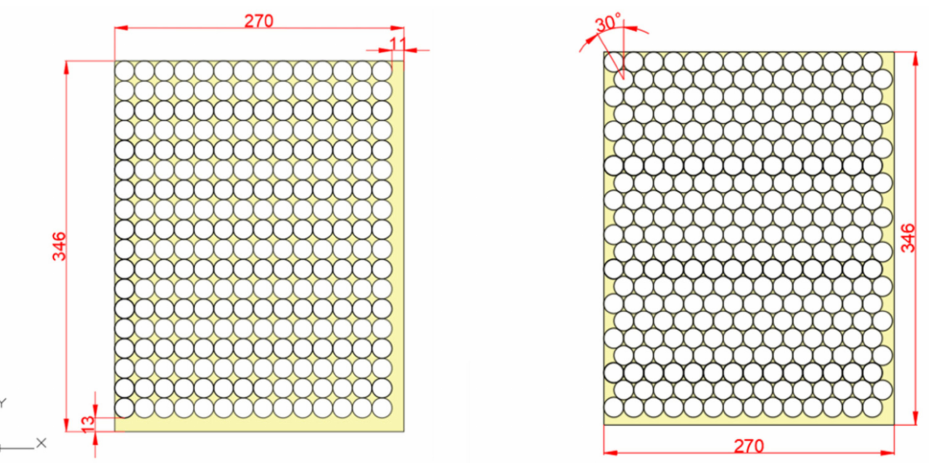
Figure 8. Reference module schematic with cylindrical cells arranged according to straight packing ( left ) and offset packing ( right